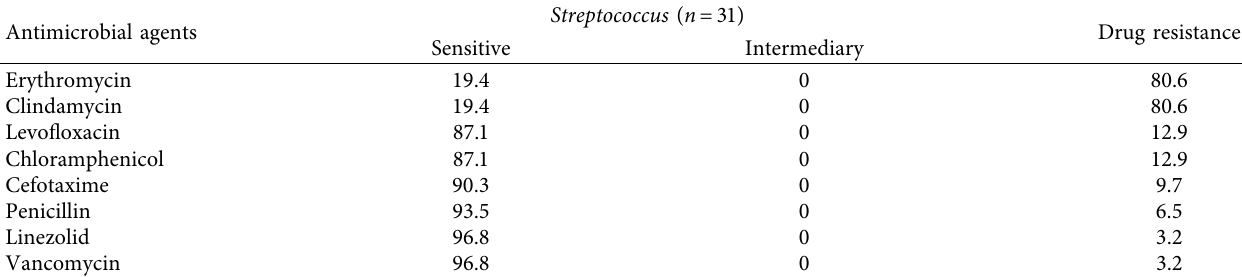
Table 7: Gram-positive Streptococcus drug resistance rate